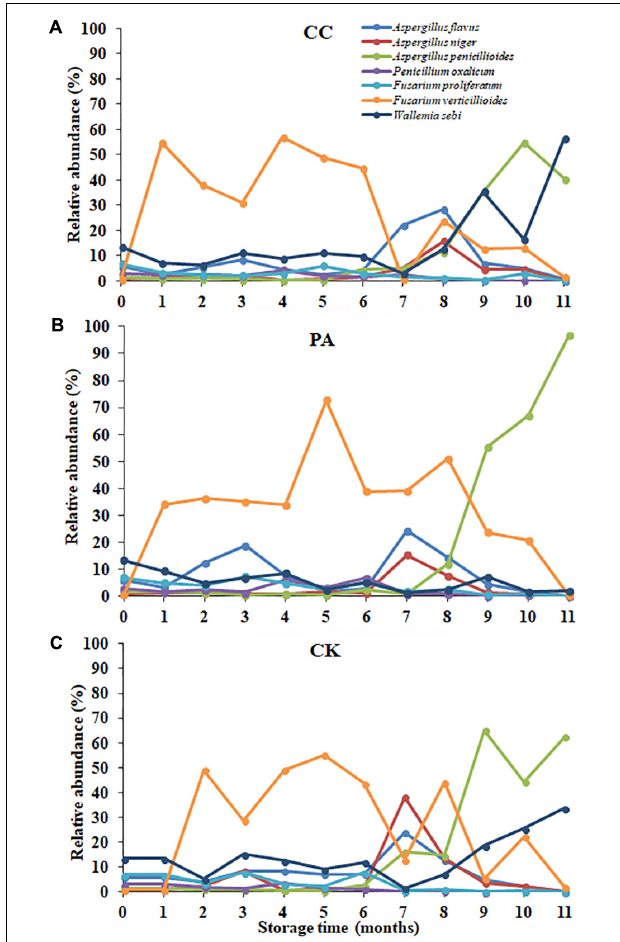
FIGURE 5 | The relative abundance of predominant taxonomic groups at species level over storage time in stored peanuts. (C) CK, control group; (B) PA, propionic acid group; (A) CC, complex essential oils